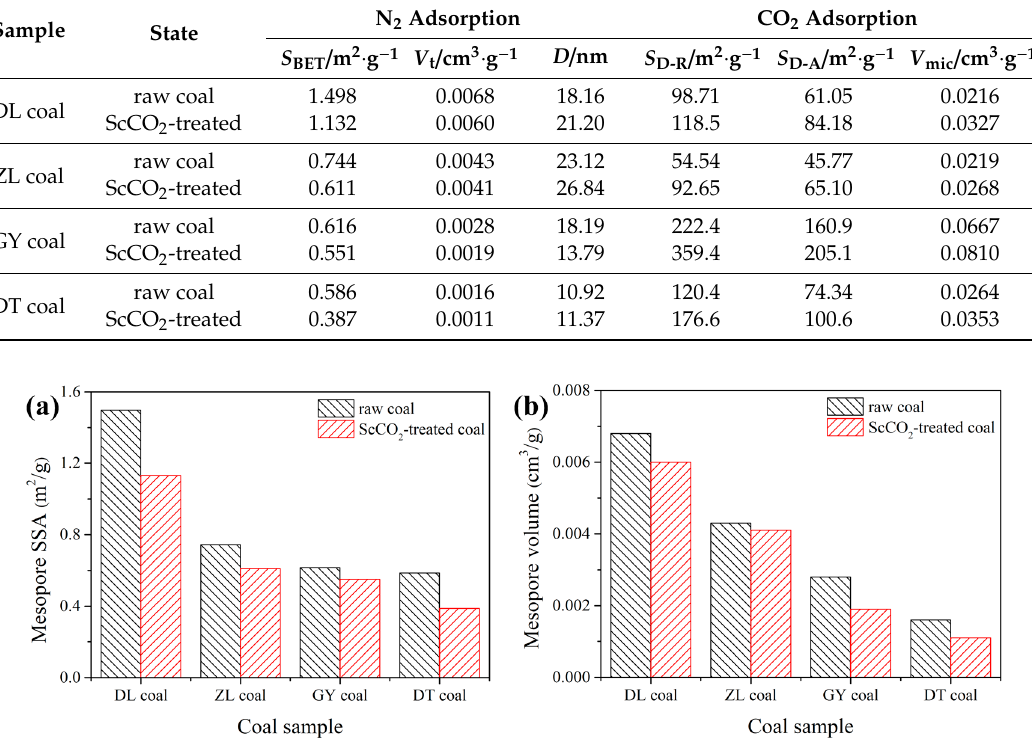
Table 2. Structural properties of the raw and ScCO 2 -treated coal samples determined by N 2 and CO 2 sorption.